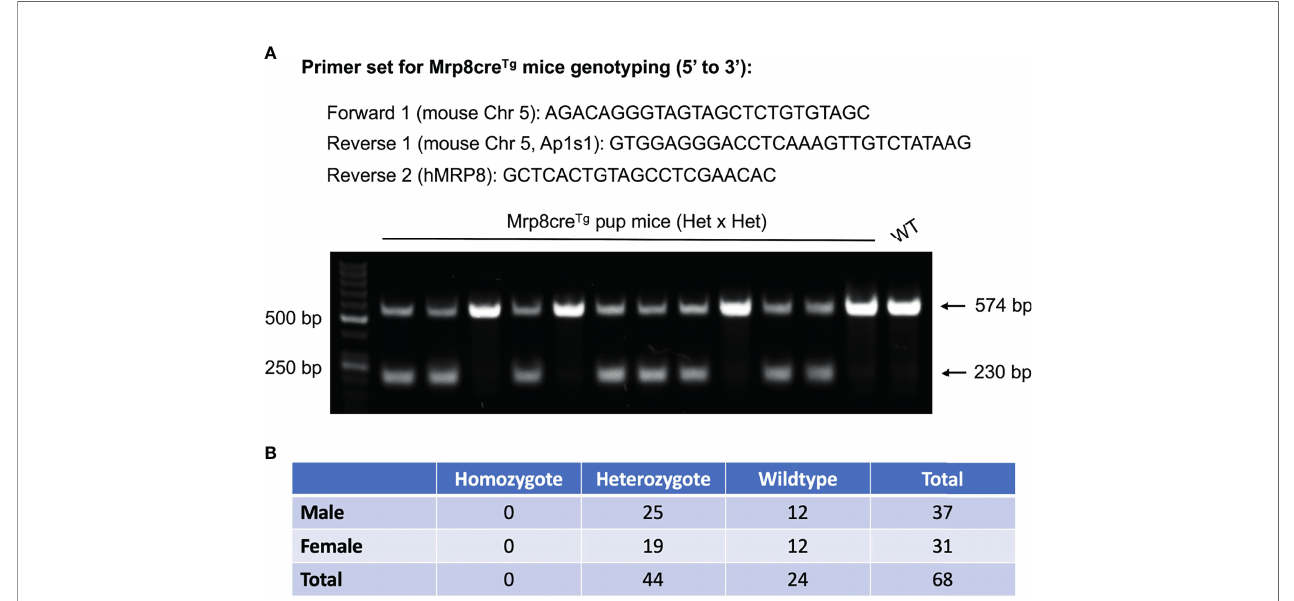
FIGURE 2 | A new genotyping protocol distinguishes the different genotypes of Mrp8cre Tg mice. (A) The primer set designed for Mrp8cre Tg mouse genotyping based on TLA sequencing results (upper panel). A representative DNA gel genotyping two litters of Mrp8cre Tg mice bred by mating male heterozygotes with female heterozygotes. Two DNA bands of 574 bp and 230 bp are observed for heterozygous pups, while only one 574 bp band is observed for wildtype pups (lower panel). (B) Amongst 68 Mrp8cre Tg pups bred from heterozygous parents, 44 heterozygous versus 24 wildtypes were detected and no homozygous pups were